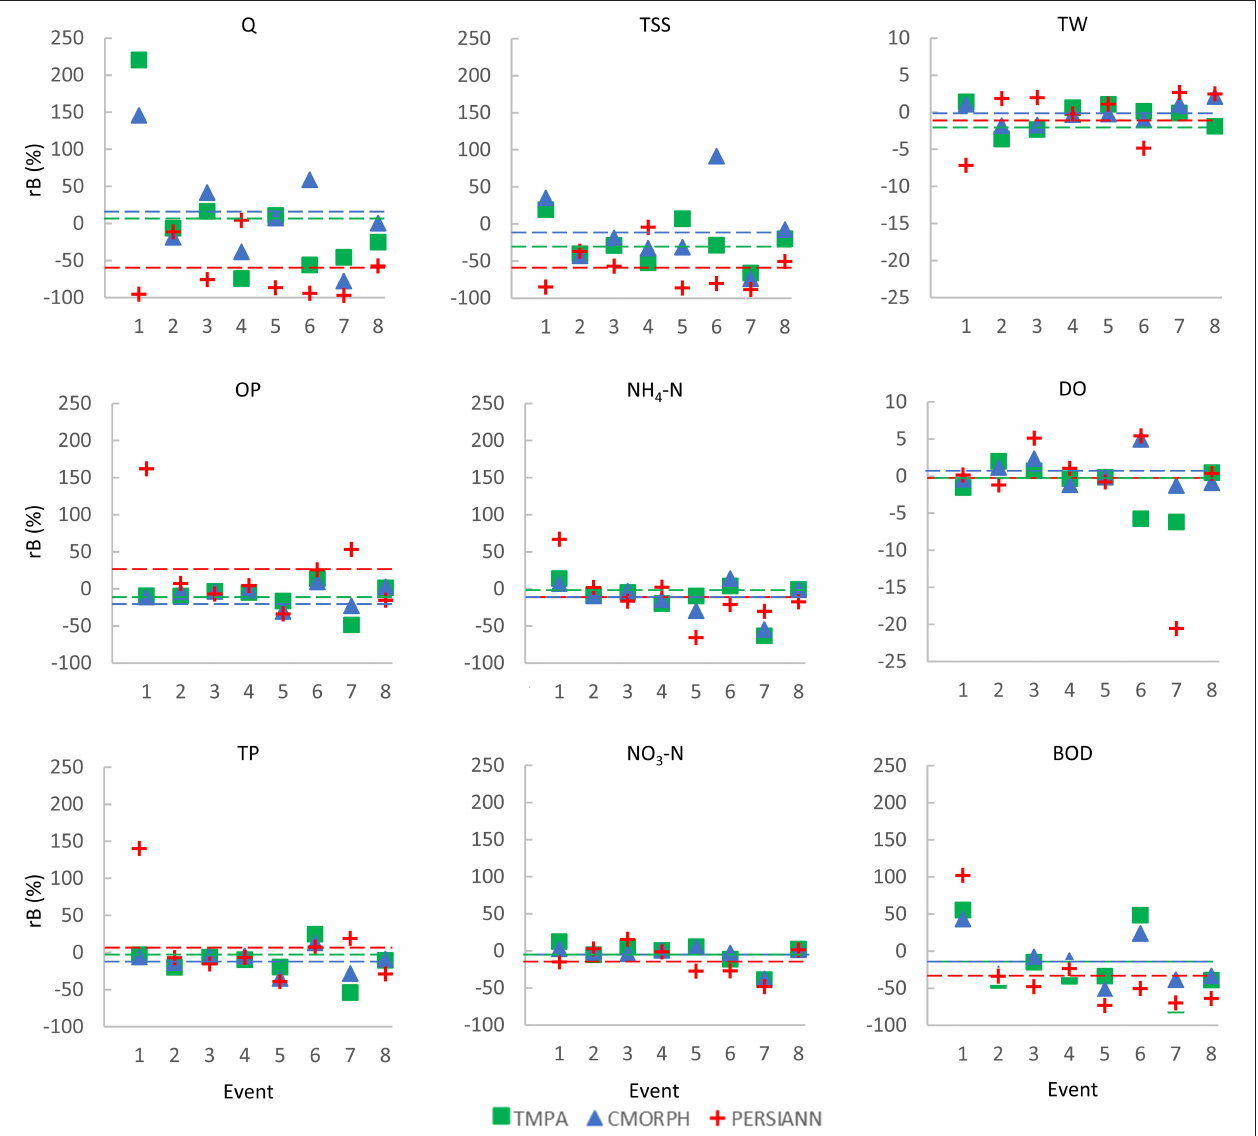
FIGURE 10 | rBs of streamflow and water quality indicators between gauge-simulated and SPP-simulated output for TMPA, CMORPH, and PERSIANN for six evaluation points. The mean indicator value across all eight events is represented by a dashed line corresponding to TMPA, CMORPH, and PERSIANN in green, blue, and red,